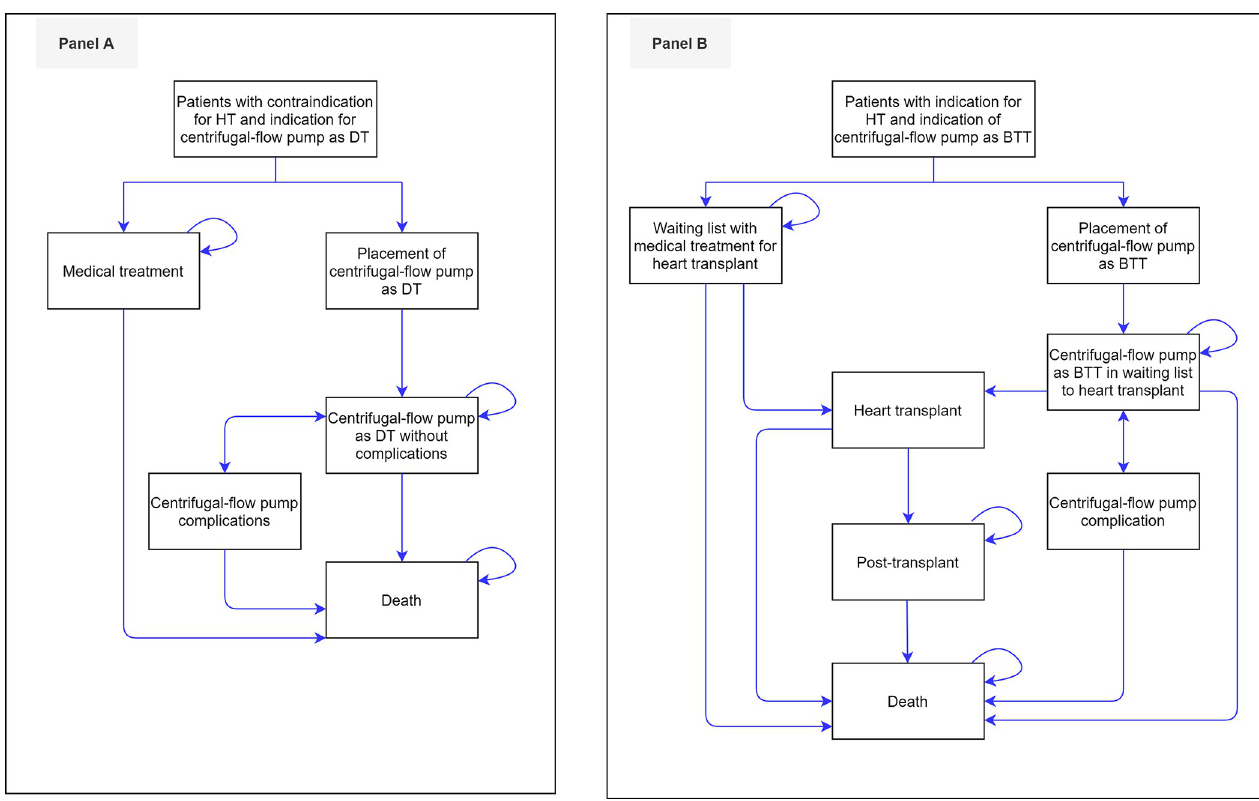
Fig 1. Panel A, Markov structure for Model 1, Panel B, Markov structure for Model 2. Abbreviations. BTT , bridge to transplant; DT , destination therapy.